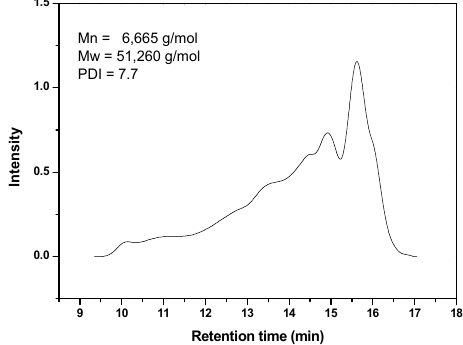
Figure 5. Gel permeation chromatogram of FMEP-PU.